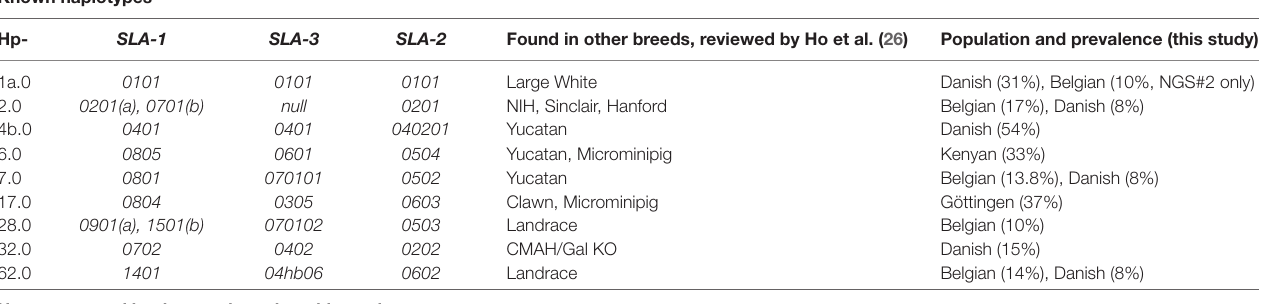
TaBle 2 | Known and novel haplotypes and their prevalence in the four different pig